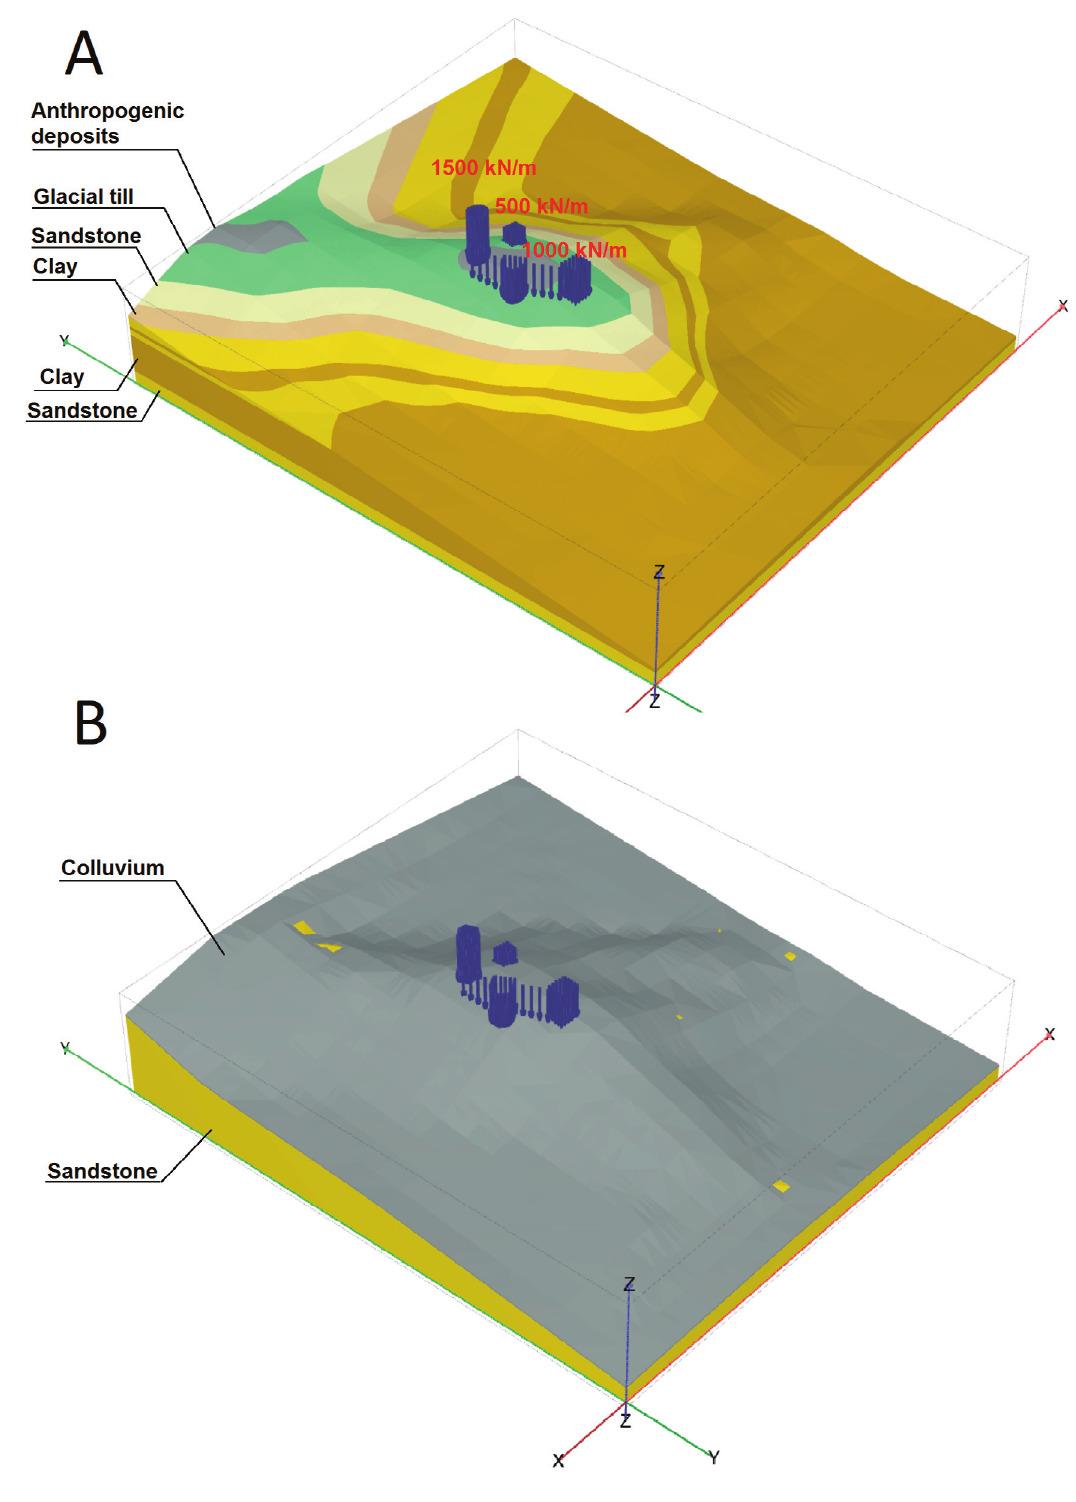
Fig. 2. Geological model of the castle mound without colluvial material ( A ) and with colluvial material and a homogeneous sublayer ( B